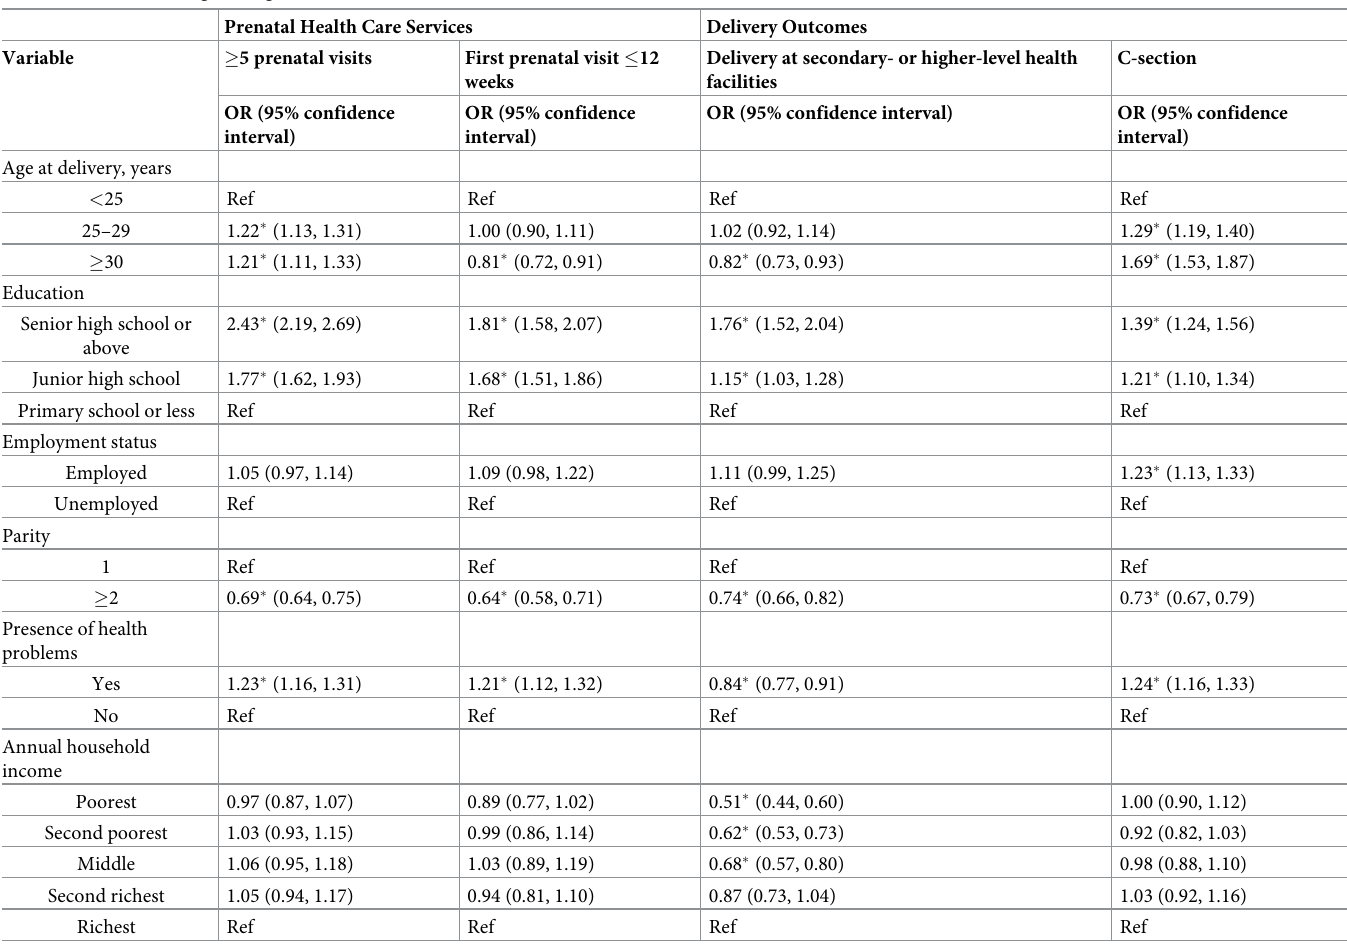
Table 5. Multivariate logistic regression of maternal health services utilization in rural